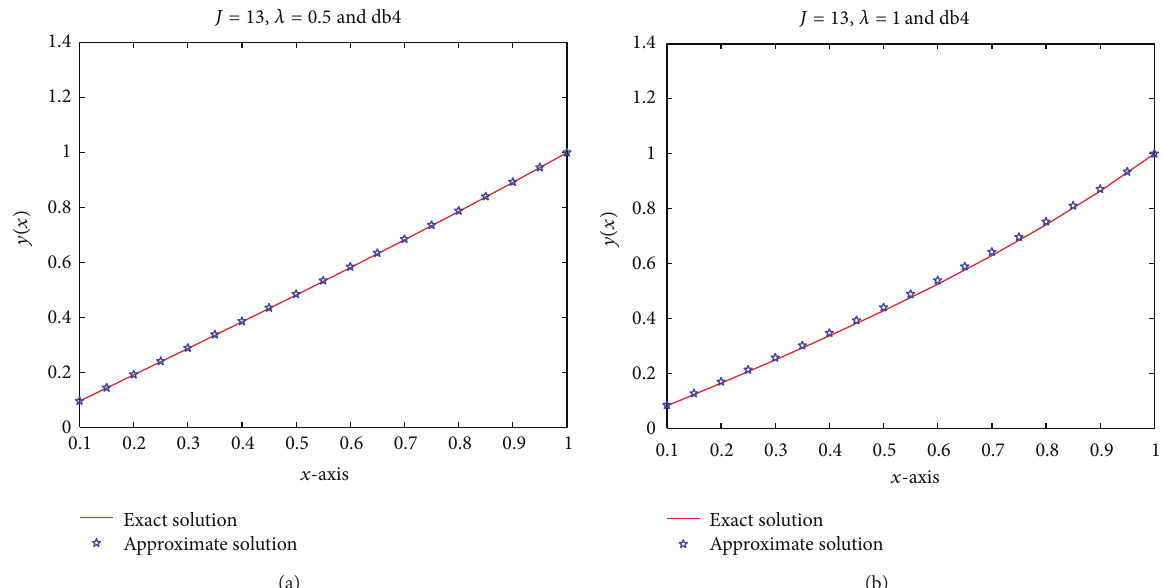
Figure 3: Comparison of exact solution and solution by wavelet-Galerkin method with quasilinearization technique at level of resolution 𝐽 = 13 and 𝐷8 is used as Galerkin bases and at 𝜆 = 0.5 and 𝜆 = 1 , respectively.